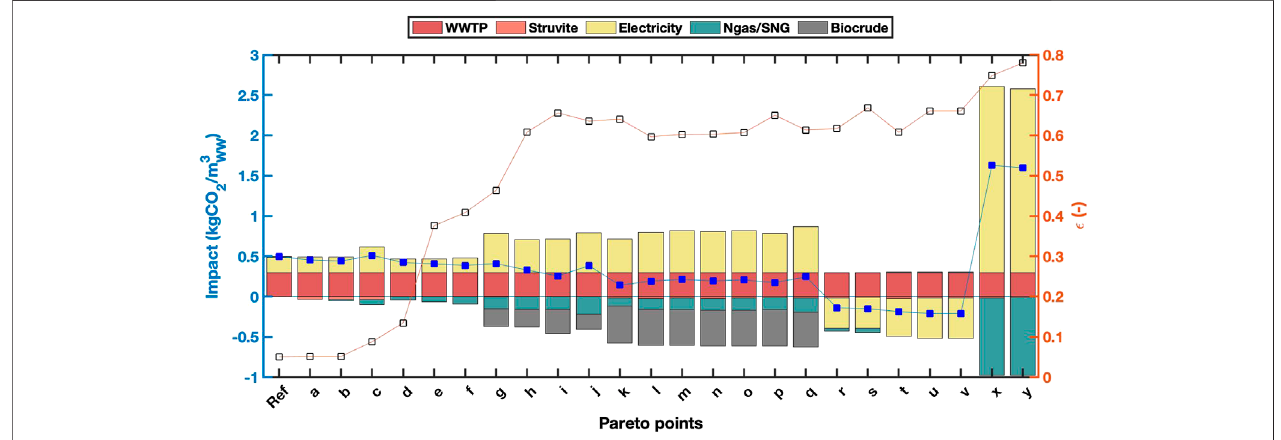
FIGURE 6 | Pareto optimal con fi guration with stacked bars corresponding to Impact partition, blue markers and line to the overall impact; orange line and axis correspond to ϵ .